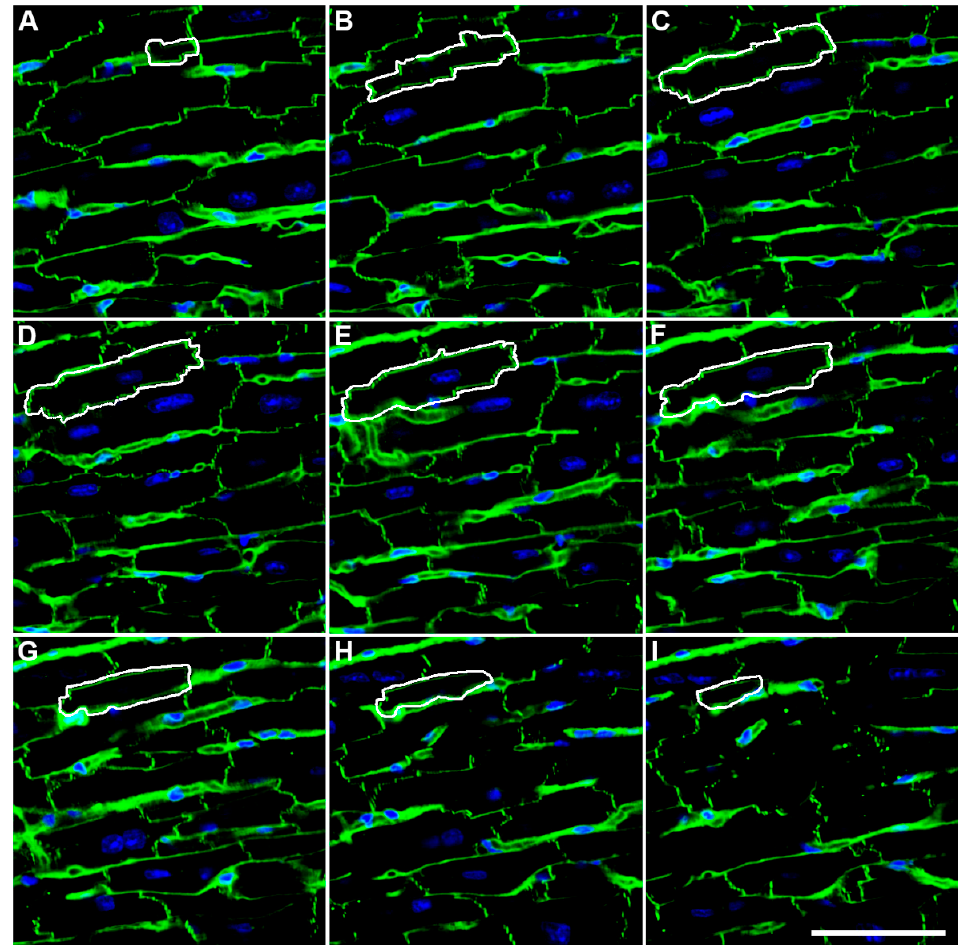
Figure 2. Estimation of the mean number of nuclei per cardiomyocyte. Consecutive optical sections ( A – I ) of a confocal microscopy z-stack are shown (( A ): top, ( I ): bottom), which were used to follow up cardiomyocytes (one example indicated by a white line) and to determine the number of nuclei present in these cells (one nucleus in the indicated myocyte, visible in D – F ). Shown are merged channels, with green = cadherin and wheat germ agglutinin, and blue = nuclei. Scale bar: 50 µm. Reprint with permission from ref. [11], Copyright 2014 John Wiley and